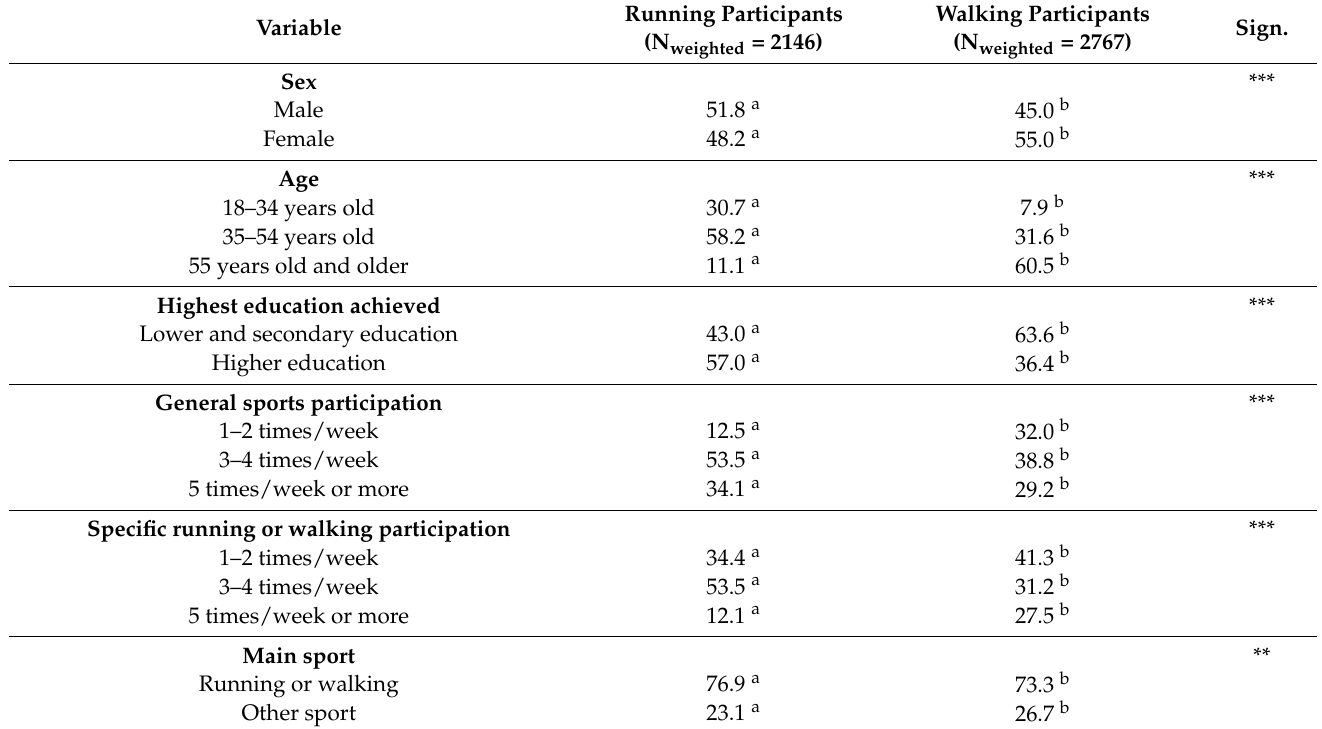
Table 4. Descriptive statistics of running and walking participants, tested with chi-square tests and Bonferroni adjustment (in